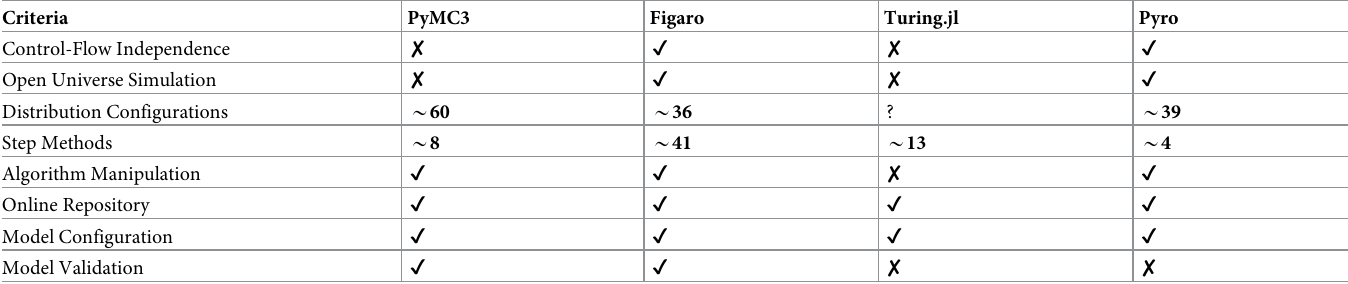
Table 2. Comparison Of extensibility Of